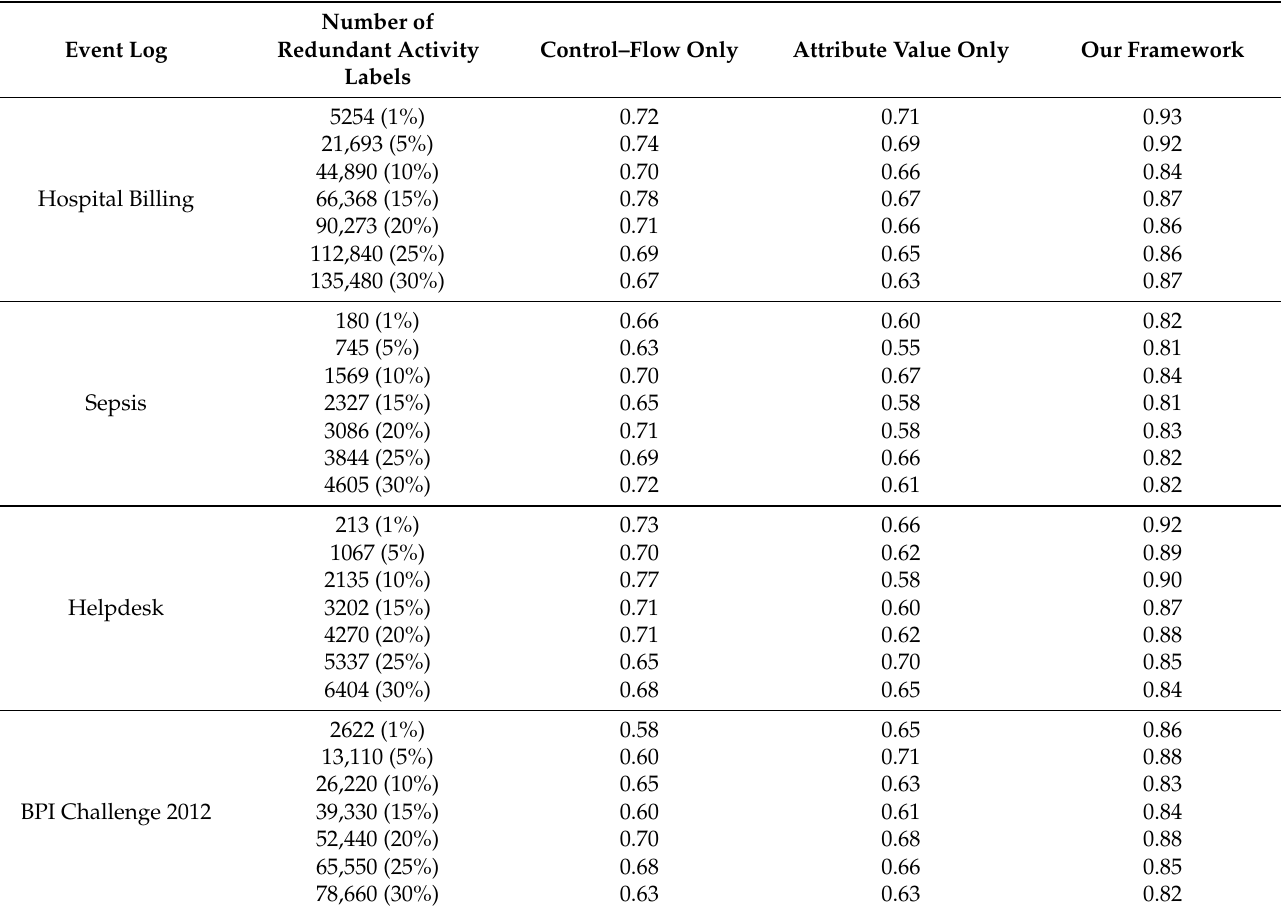
Table 3. Further analysis of our framework